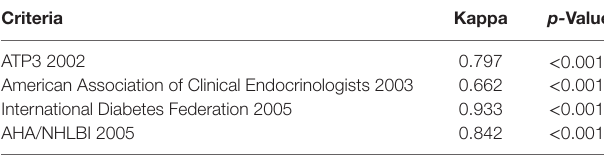
TaBle 7 | Inter-definition agreement for metabolic syndrome diagnosis.